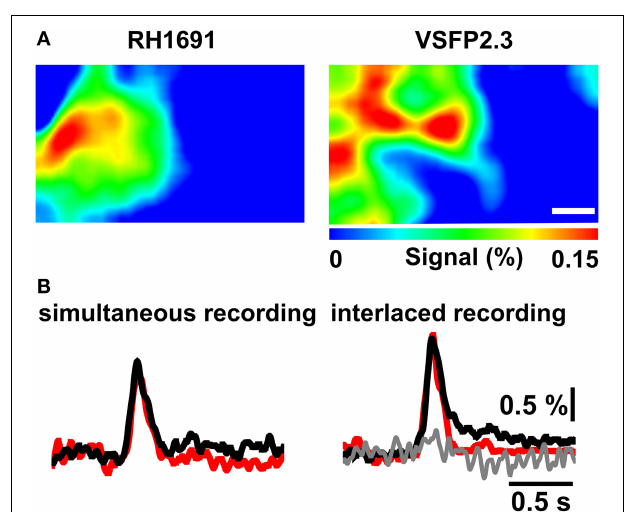
FIGURE 5 | Combined VSFP2.3 and RH1691 voltage imaging using interlaced and simultaneous recording modes. (A) Representative peak population membrane voltage signal during a brief C1 whisker deflection imaged with RH1691 (left) and VSFP2.3 (right) using three synchronized CCD cameras (simultaneous recording mode). Scale bar, 1 mm. (B) Left VSFP2.3 (black) and RH1691 (red) traces are sampled from (A) by a simultaneous recording mode. Right traces are also samples from the same mouse, but acquired using the interlaced VSFP2.3 (black) and RH1691 (red) recording mode. Gray trace is obtained from the RH1691 channel during the VSFP2.3 excitation in the interlaced mode. Note that VSFP2.3 Citrine fluorescence changes do not interfere with RH1691emission. Images and traces represent a 50-trial